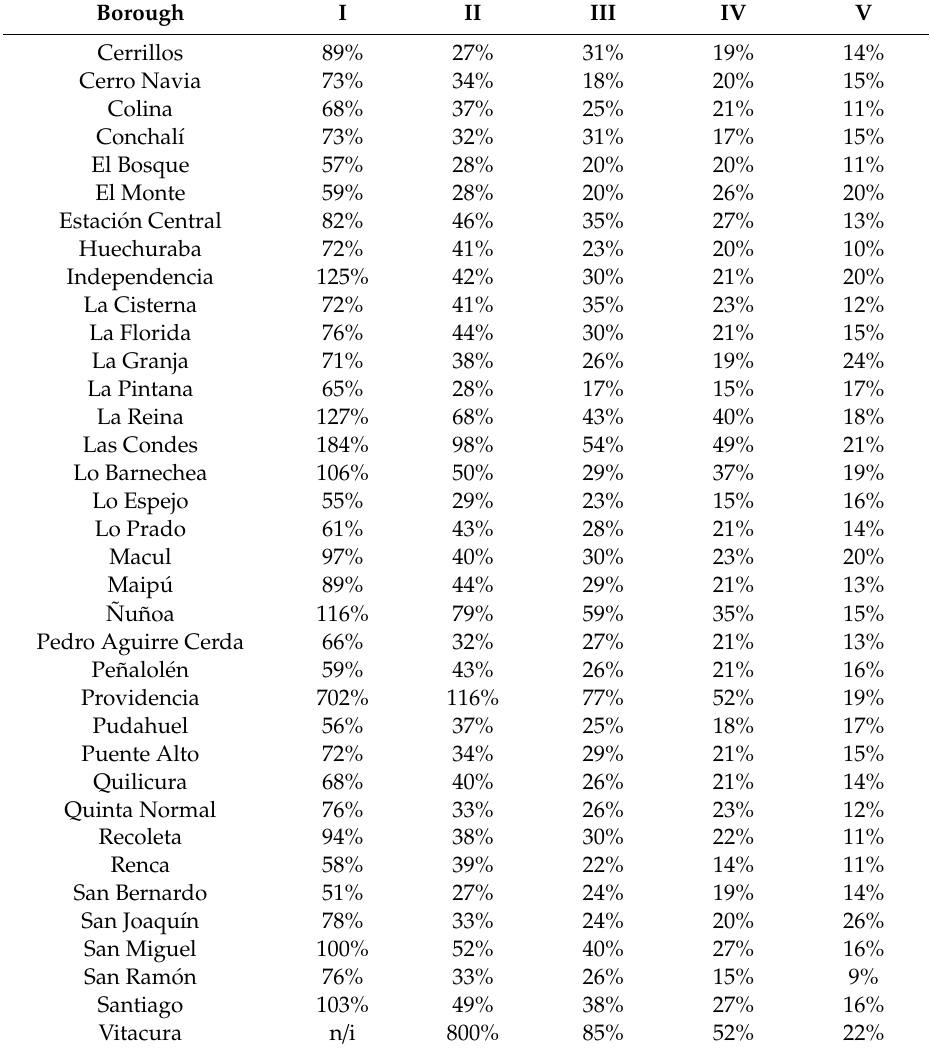
Table 2. The weight of the rental price on the labour income of households. Numbers above 30% are considered as non-a ff ordable housing prices. Please see further detailes in Table A1. Source: Prepared and calculated by the authors based on the CASEN 2017 survey